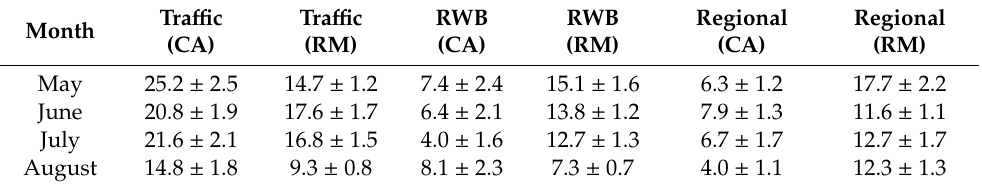
Table 4. Ambient PM 2.5 source apportionment ( ± standard error), Santiago, May–August 2004 ( µ g / m 3